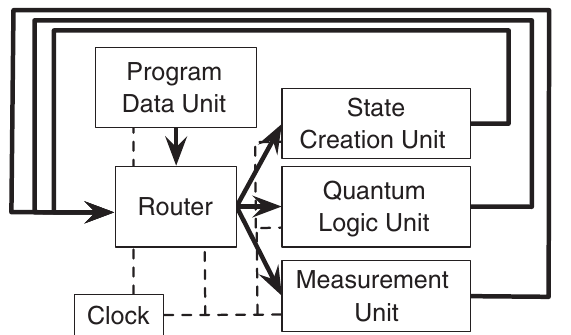
FIG. 3. Using quantum transistors, one can design a synchro- nous architecture as shown. A router takes classical information about what circuit should be executed (the quantum program) and routes it to the appropriate action unit. These units are made up of a collection of quantum transistors that can be used to implement their given functions. This information is then di- rected to the router, where another step in the circuit begins by reading the next program